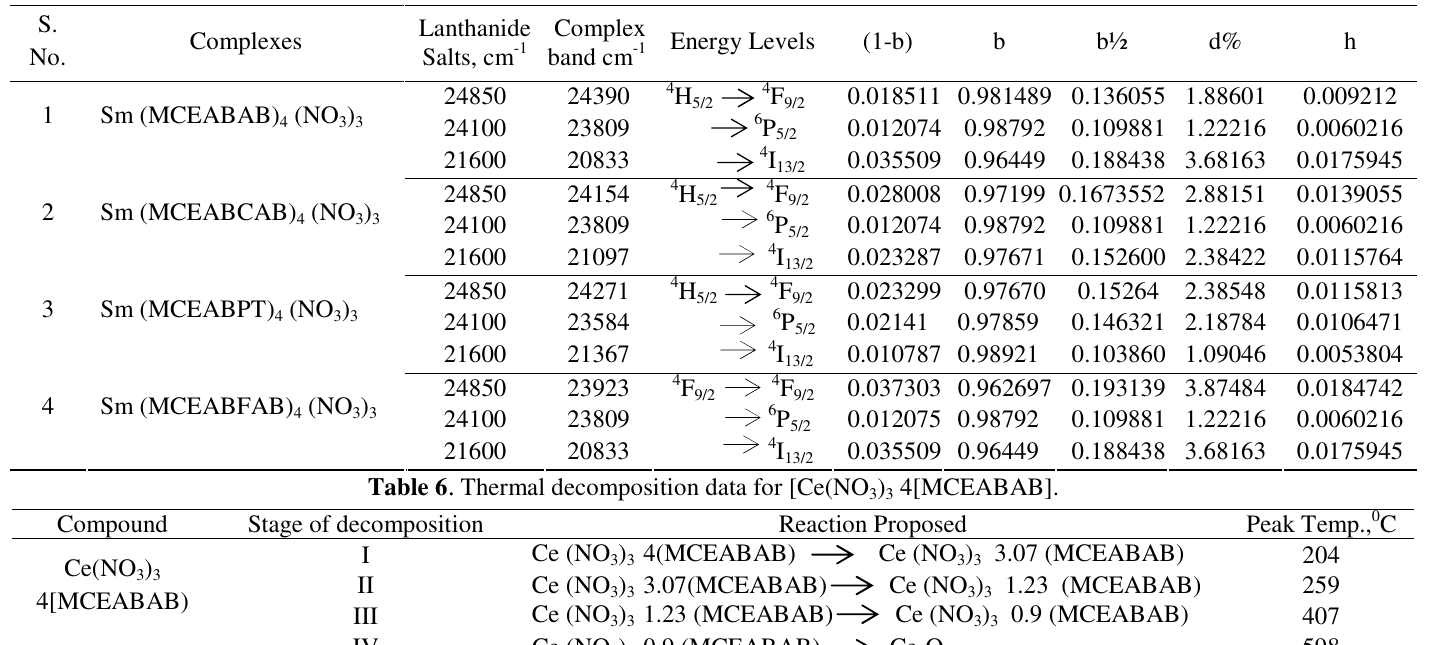
Table 5. Electronic spectral data (cm -1 ) and related bonding parameter of lanthanide(III) nitrate complexes of Schiff bases.